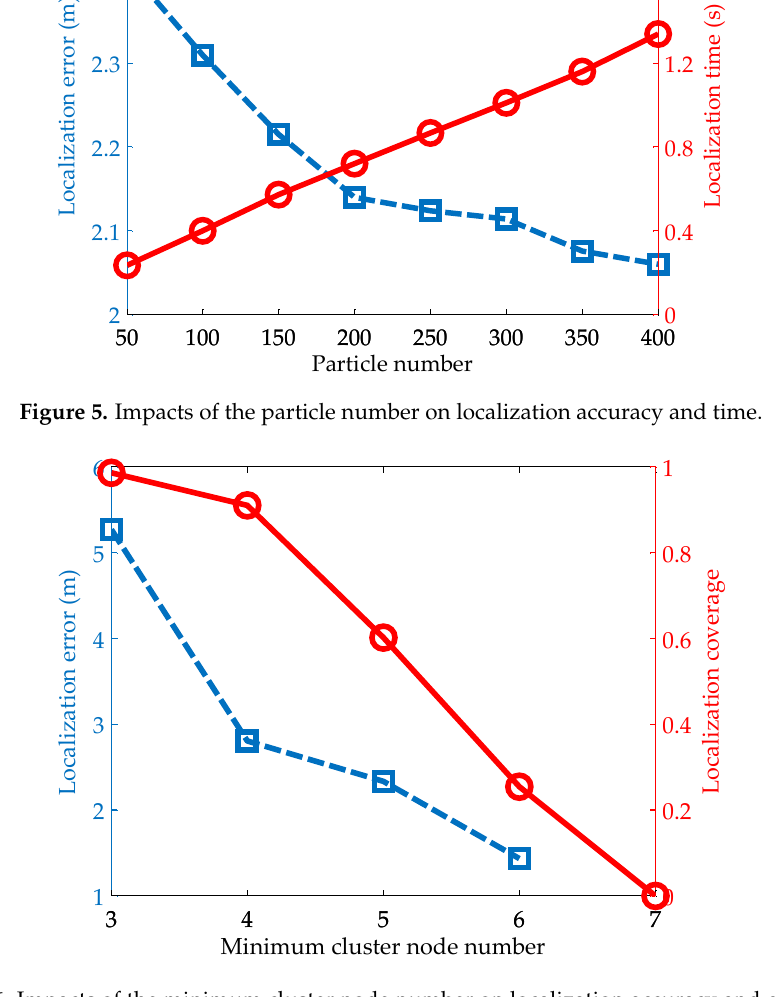
Figure 6. Impacts of the minimum cluster node number on localization accuracy and